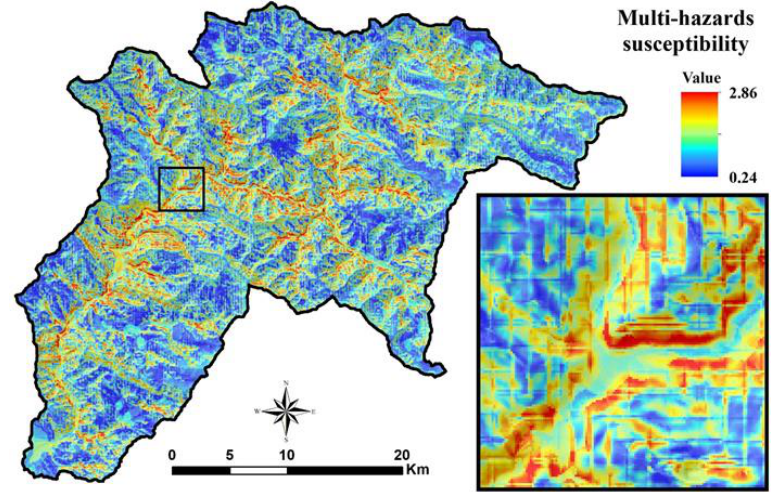
Figure 7. Multi-hazard susceptibility map of the study area.